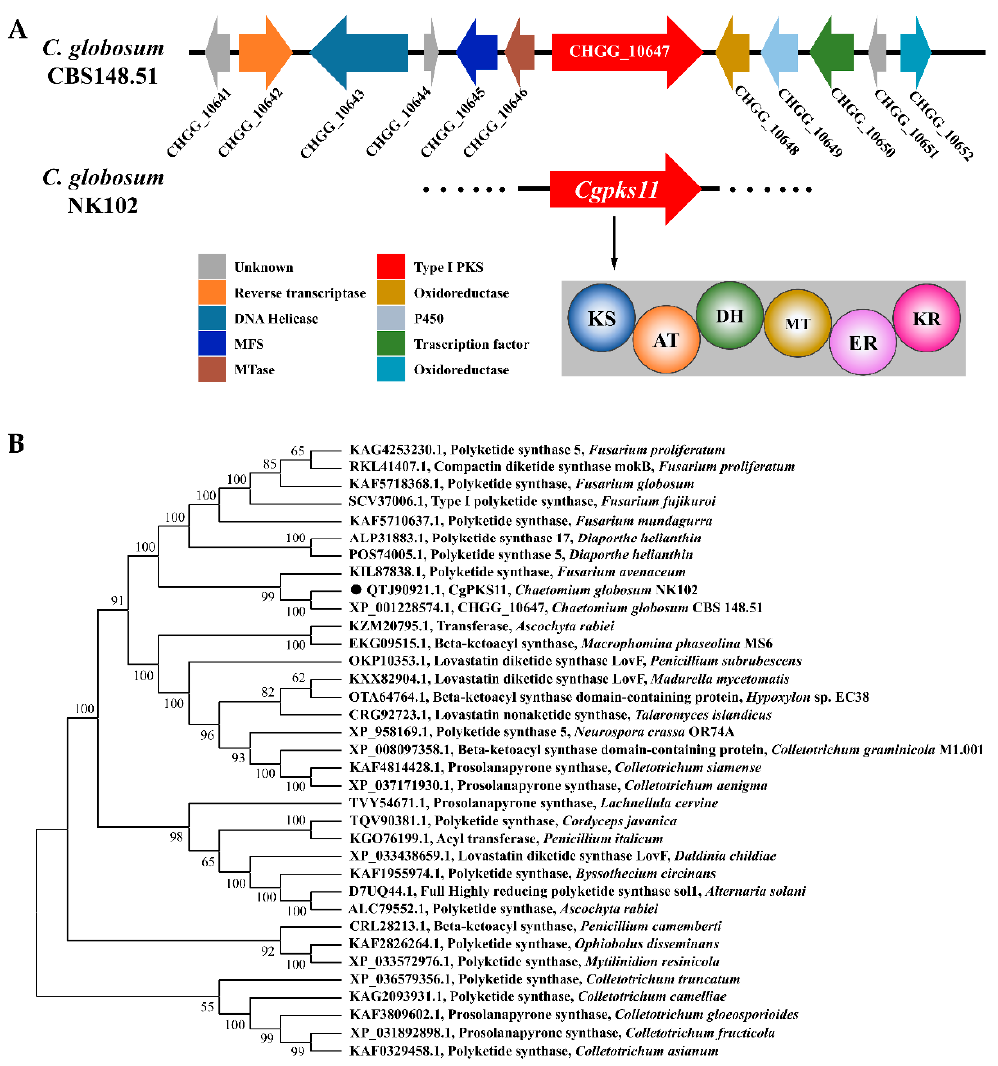
Figure 2. Prediction and phylogenetic analysis of the CgPKS11 in C. globosum . ( A ) The organization of the chaetoglocin A biosynthetic gene cluster in C. globosum . The predicted function of genes in this cluster are shown by different colors. The predicted functional domains of CgPKS11 are represented by colored circles: KS = ketosynthase, AT = acyltransferase, DH = dehydratase, MT = methyltransferase, ER = enoyl reductase, and KR = ketoreductase. ( B ) A phylogenetic tree based on the full-length amino acid sequences of CgPKS11 and another 34 homologous PKSs. Phylogeny was inferred by the NJ method implemented in MEGA Ⅹ under the JTT matrix-based method. Bootstrap supports > 50% from 1000 replicates per run are labeled on branch nodes. Polyketide synthases in Colletotrichum spp. were designated as the outgroup. CgPKS11 from the C. globosum NK102 clade was marked in black dot.